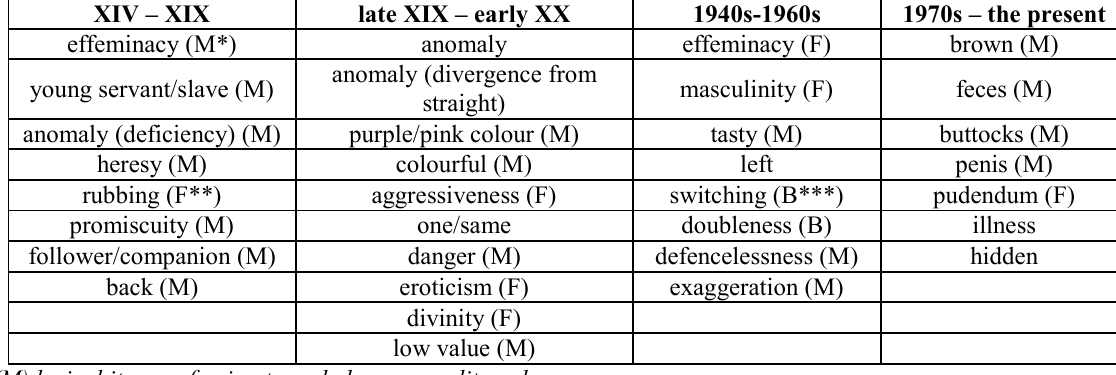
Table 1 – The evolution of nominative foci in the lexical field